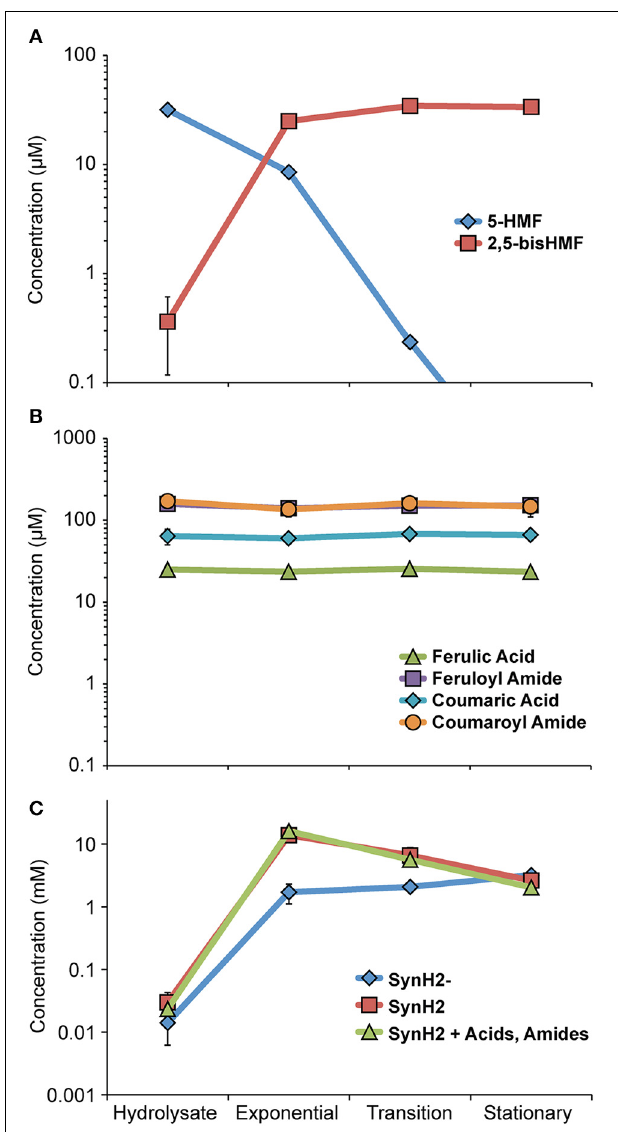
FIGURE 3 | Growth phase-dependent changes in SynH2 aromatic inhibitor levels. GLBRCE1 was cultured under anaerobic conditions in SynH2 in bioreactors. Levels of the major LC-derived inhibitors in the culture medium were determined as described in Materials and Methods. “Hydrolysate” refers to medium immediately prior to inoculation, “Exp,” “Trans,” and “Stat” refers to samples collected during exponential, transition, and stationary phase growth, respectively. (A) Metabolic fate of hydroxymethylfurfural (HMF). Concentrations of HMF and 2,5-bis-HMF (2,5-bis-hydroxymethylfurfuryl alcohol) are represented. (B) Metabolic fates of the major aromatic acids and amides. Concentrations of ferulic acid, feruloyl amide, coumaric acid, and coumaroyl amide are shown. (C) Concentration of acetaldehyde in the culture medium when GLBRCE1 was grown in SynH2, SynH2 − , or SynH2 with aromatic aldehydes only omitted.